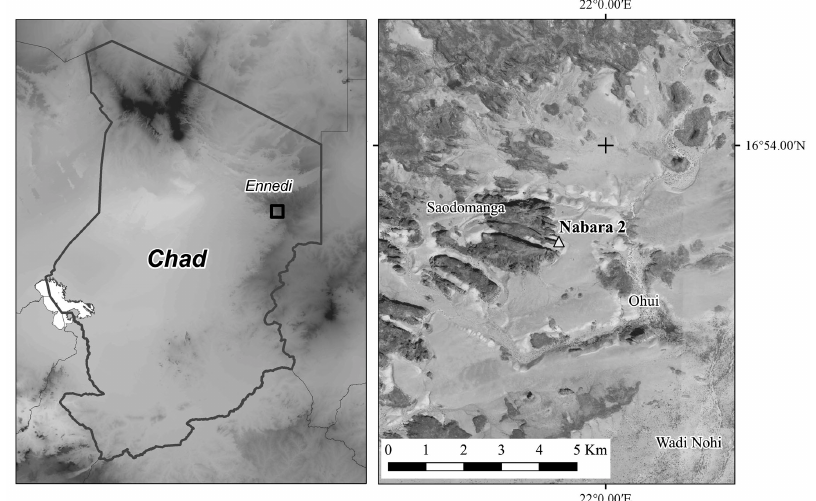
Figure 1. Location map of the Nabara 2 shelter. The satellite image in the background is from